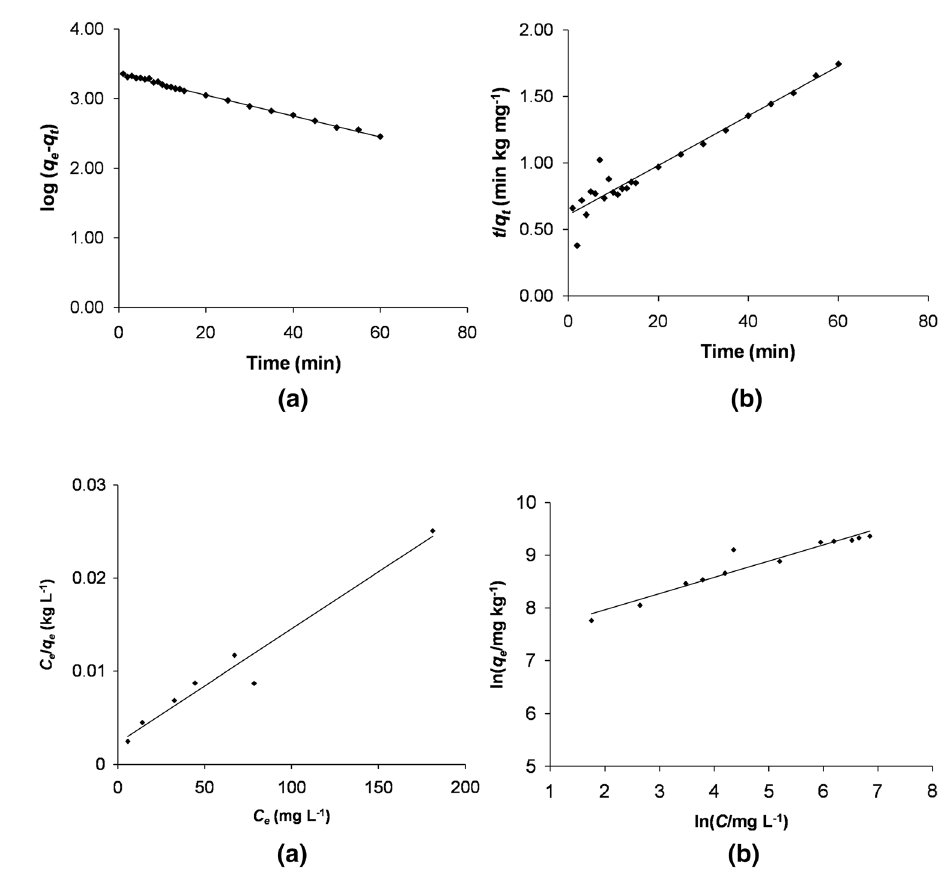
the eluent as a function of effluent volume ( V rate of 16.0 mL min −1 , is shown in Fig. 7. Similar shapes for breakthrough curves were obtained for other flow rates ranging from 4.8 to 16.0 mL min −1 as well. The common